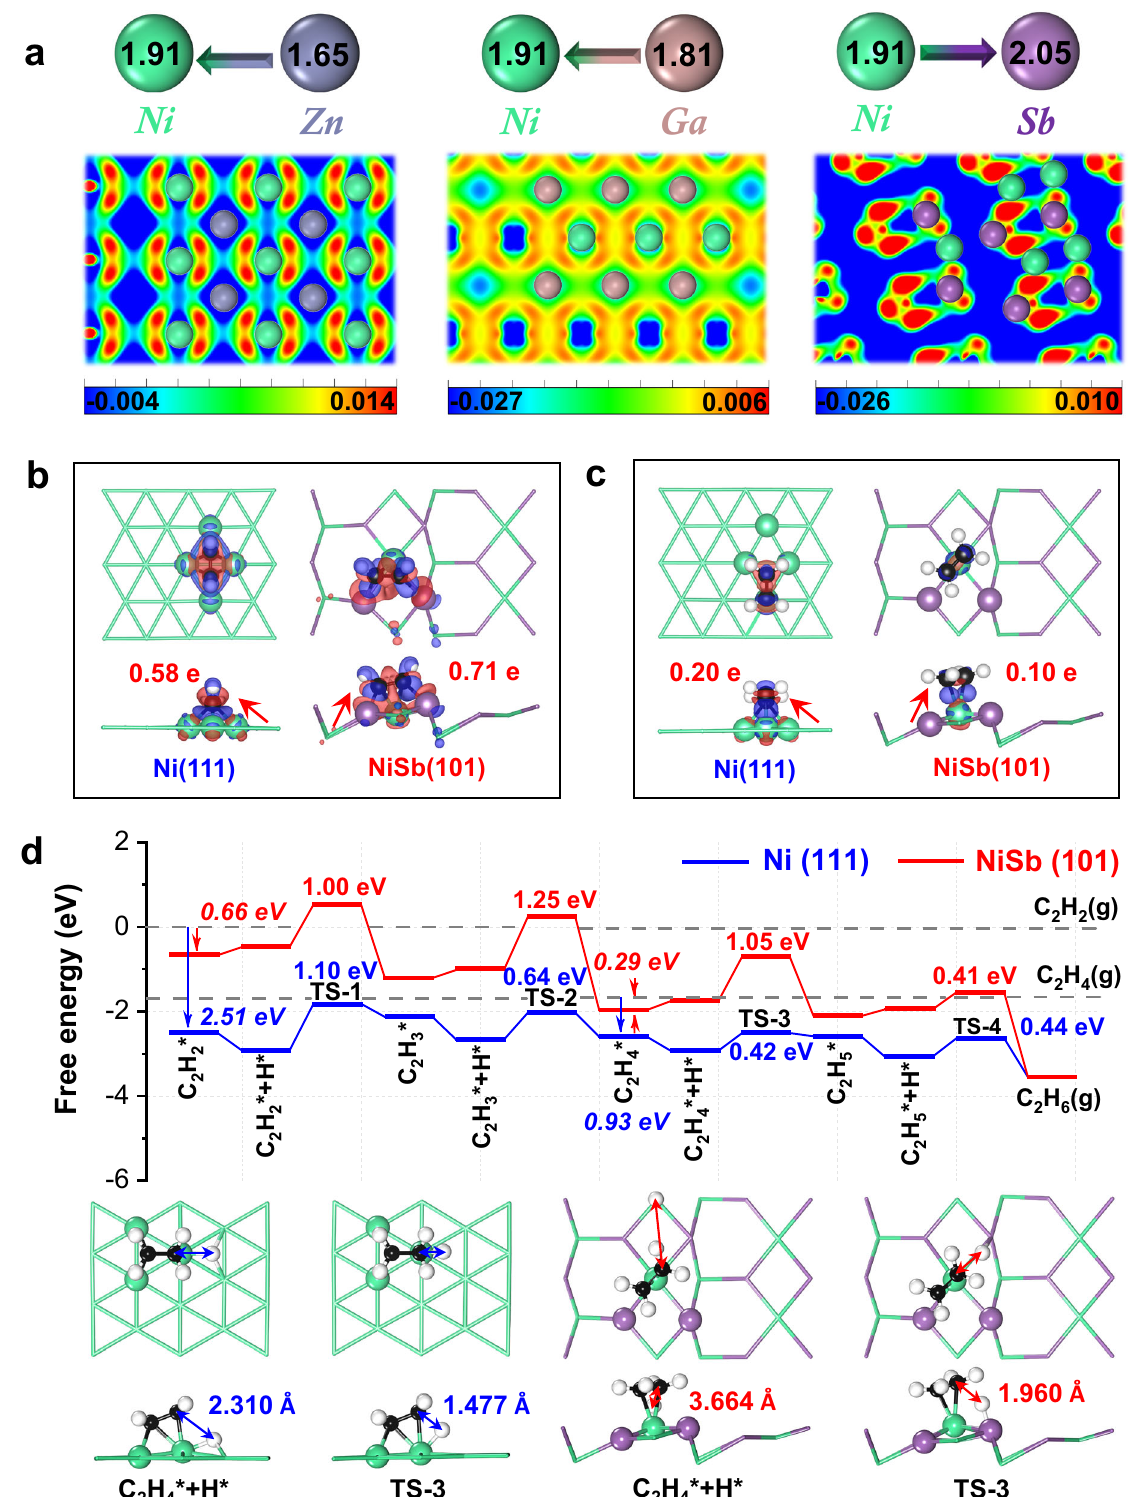
Fig. 1 | Theoretical insights into trimer Ni 1 Sb 2 site. a Two-dimensional contours of the charge density difference of NiZn(110), NiGa(110), and NiSb(101) surfaces, where the units of the color bars are e·Bohr − 3 . Top and front views on the adsorptioncon fi gurationsofacetylene( b )andethylene( c )adsorbedonNi(111)and NiSb(101)surfaces,aswellasthecorrespondingchargedensitydistributionsbased onBaderchargeanalyses.Theredandblueisosurfacesrepresenttheaccumulation